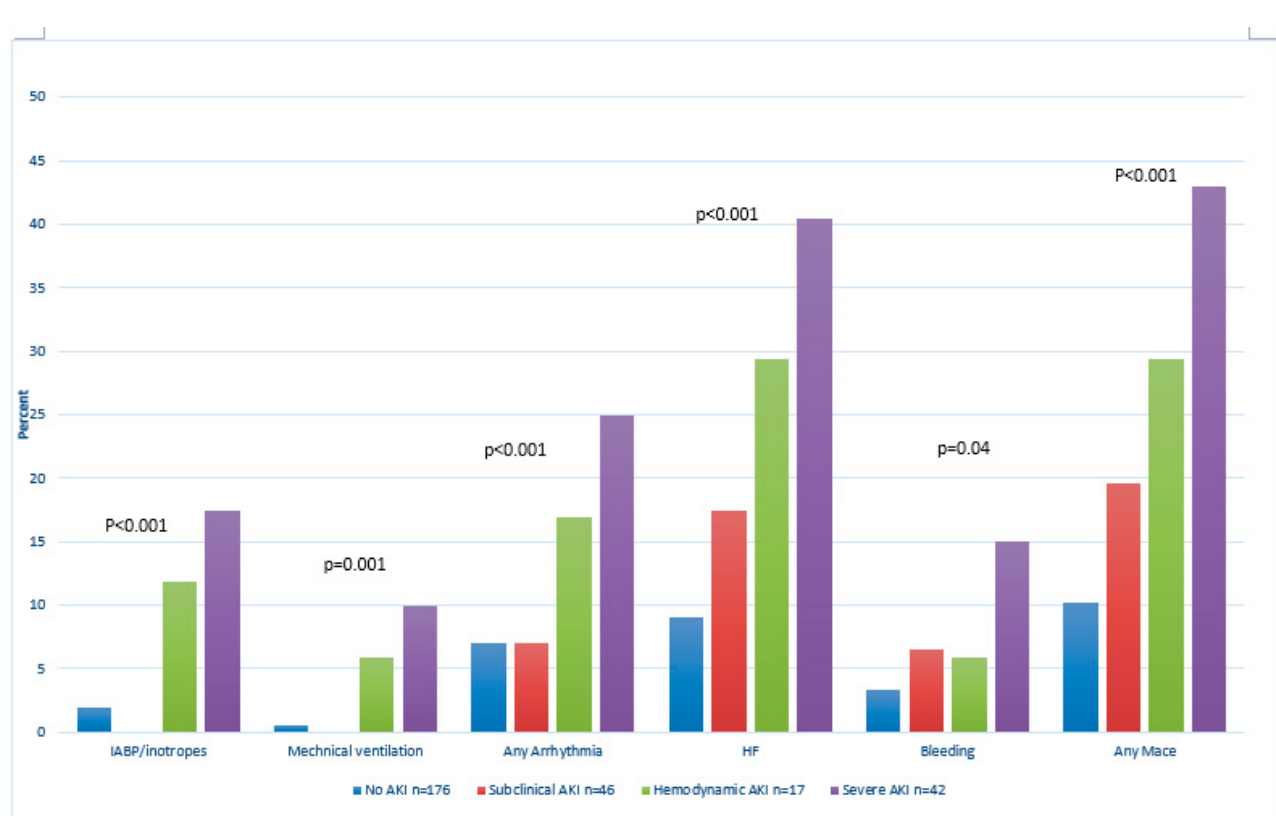
Figure 2. The in-hospital complications according to AKI phenotypes—each complication is presented in a different plot, p -value was calculated for trend between the groups. Abbreviations, MACE—major adverse cardiac event. Table 2. Multivariate regression for the occurrence of any MACE. 95% Confidence Interval HR for MACE p -Value Lower